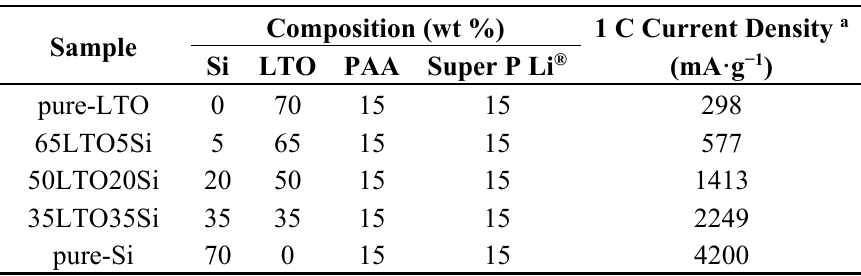
Table 1. Summary of LTO/Si